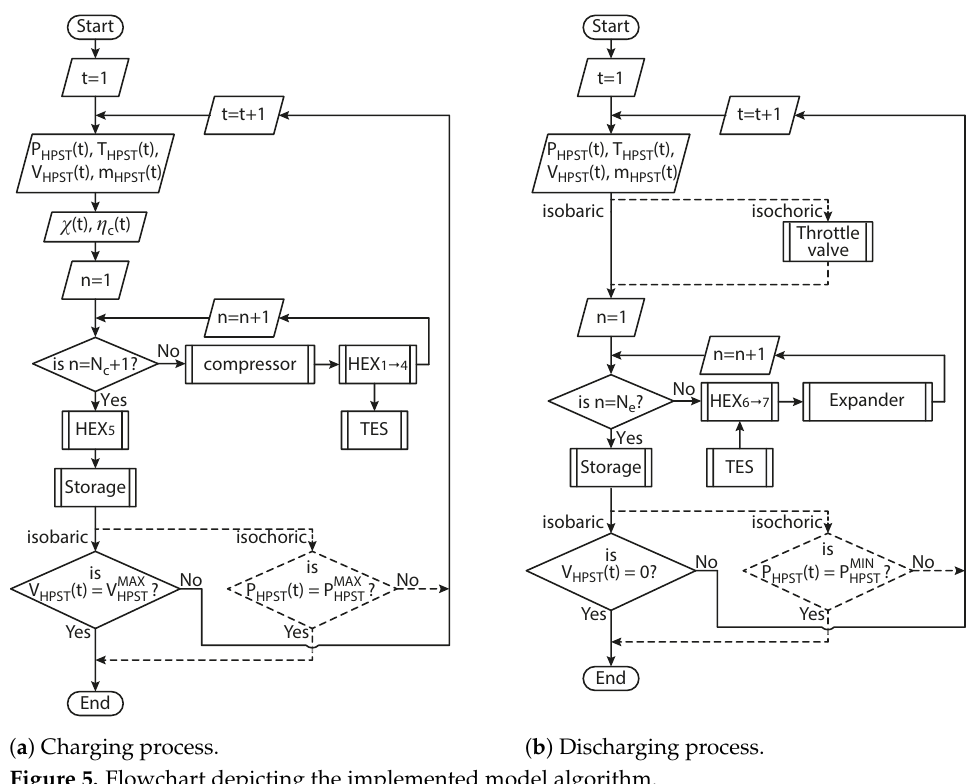
Figure 5. Flowchart depicting the implemented model